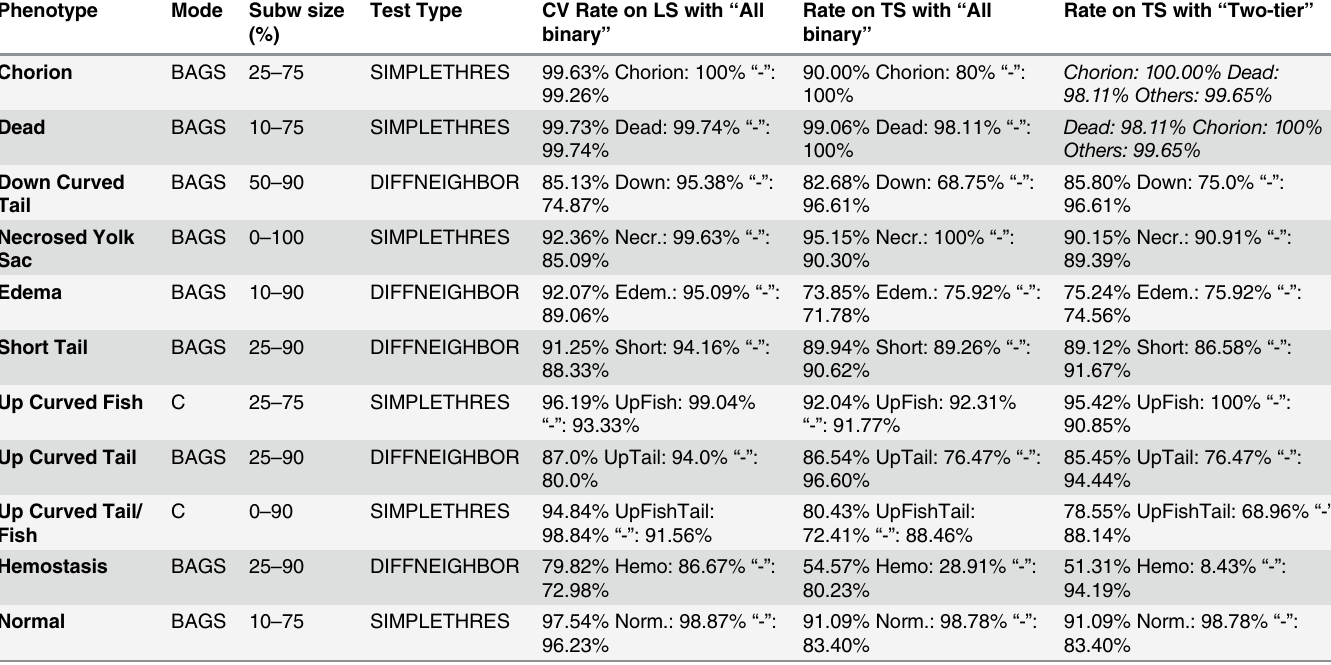
Table 3. Summary of the classi fi cation results in cross-validation on the learning sets and on the independent test sets using the “ All binary ” or “ Two-tier ”